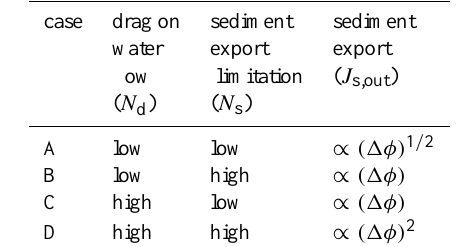
Table 4. Different dependencies of sediment export, J s,out , on geopotential difference, 1φ , (or slope) for different cases of dimen- sionless numbers N d and N s